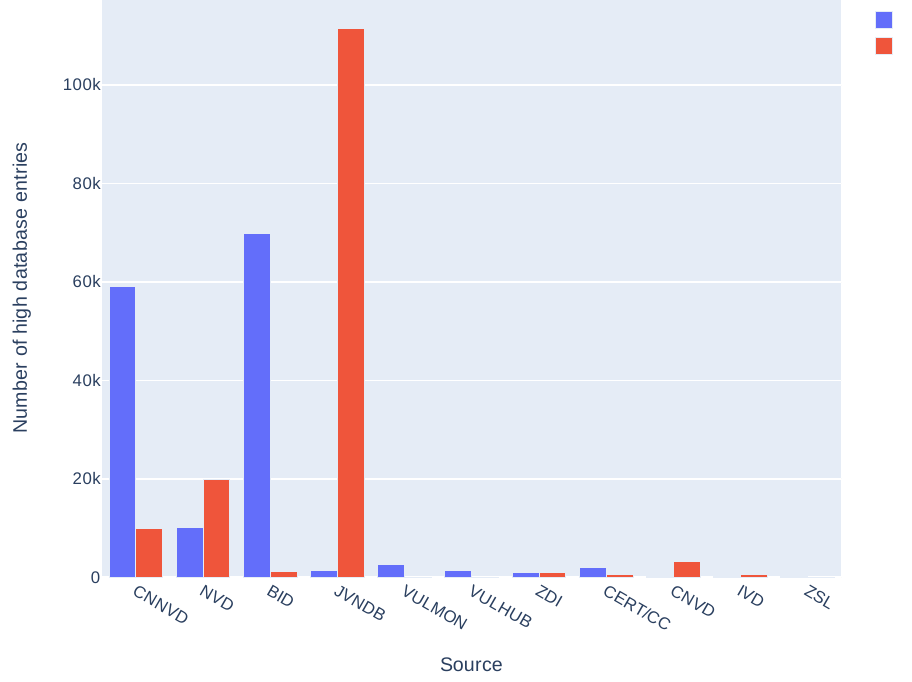
Figure 8. Number of entries in the high database where given database reported vulnerability as a first one or a last